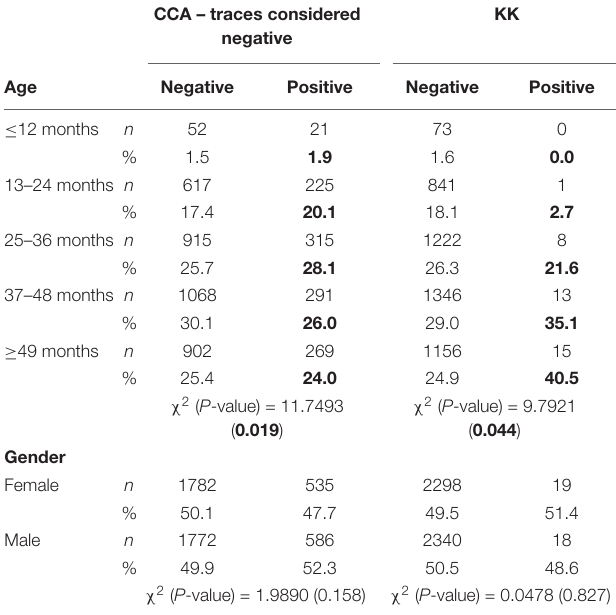
TABLE 4 | Infection prevalence per age category and